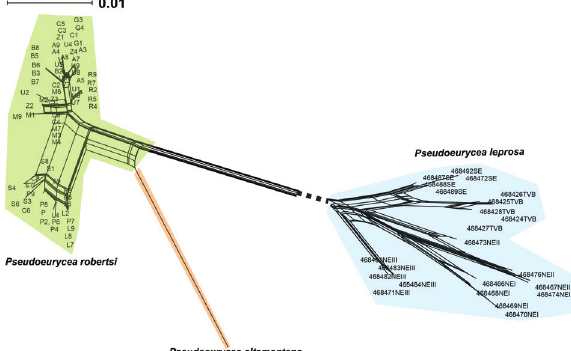
Figure 3. Haplotype network obtained with the Neighbor-Net algorithm. P. robertsi clusters are shown in green, P. leprosa are shown in blue and P. altamontana are shown in orange. Scale bar are substitutions per